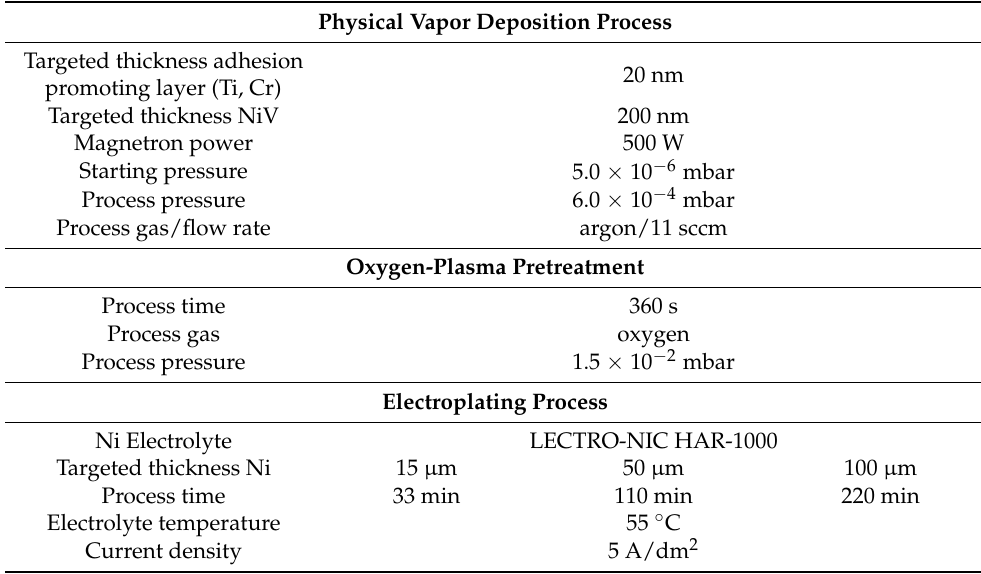
Table 1. Process parameters of the physical vapor deposition, oxygen plasma pretreatment and electroplating